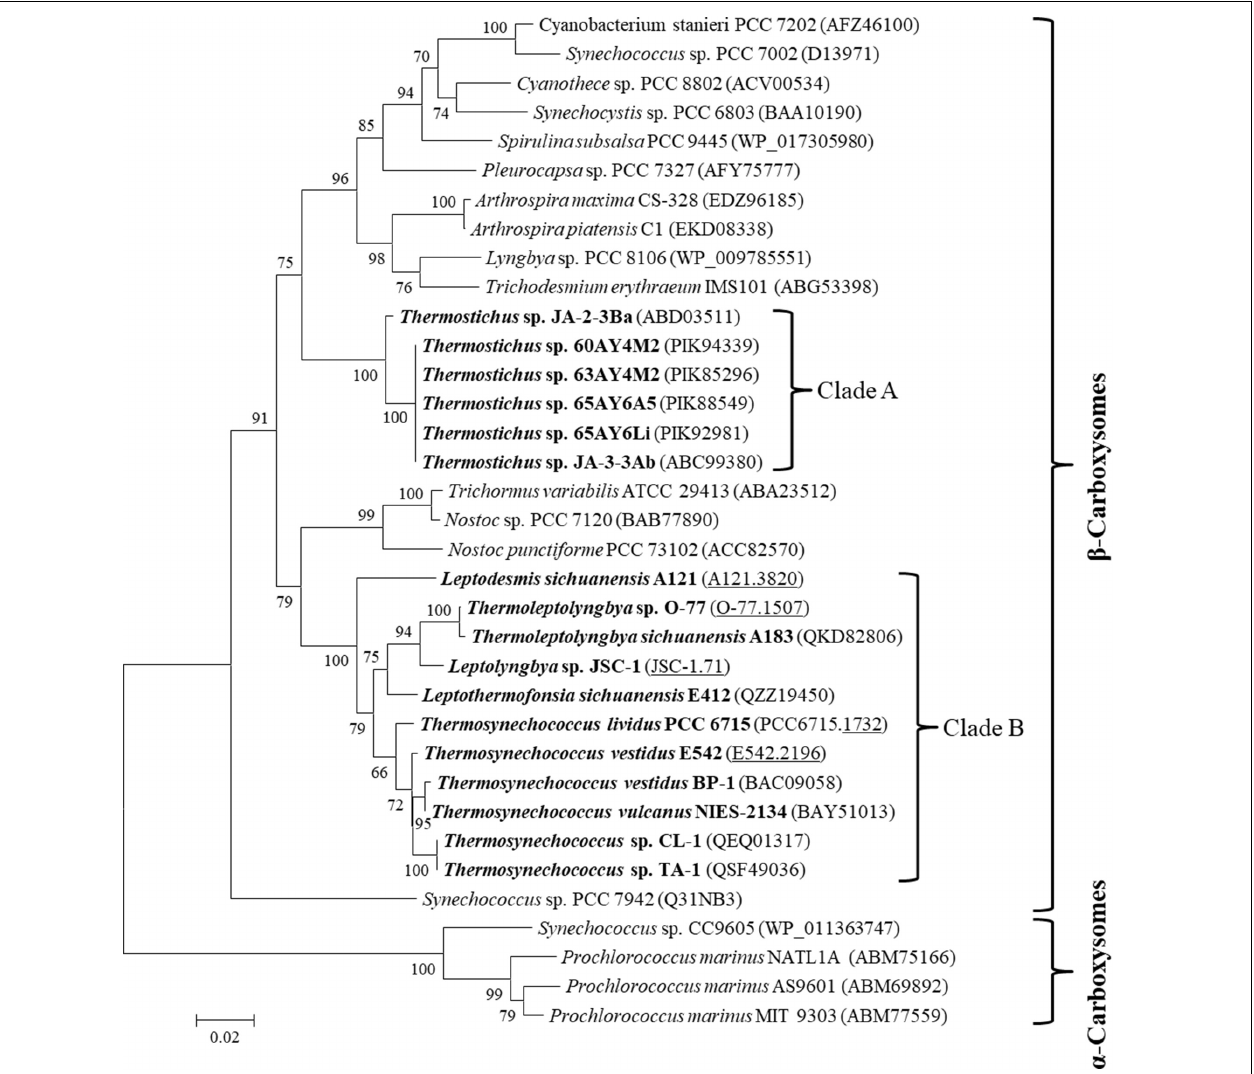
FIGURE 2 | Phylogenetic inference of Rubisco large subunit protein sequences. The thermophilic cyanobacteria investigated in this study are indicated in bold. The accession numbers underscored refers to the gene IDs in Supplementary Table 1 . Only bootstrap values > 50% are indicated at nodes. Scale bar = 1% substitutions per